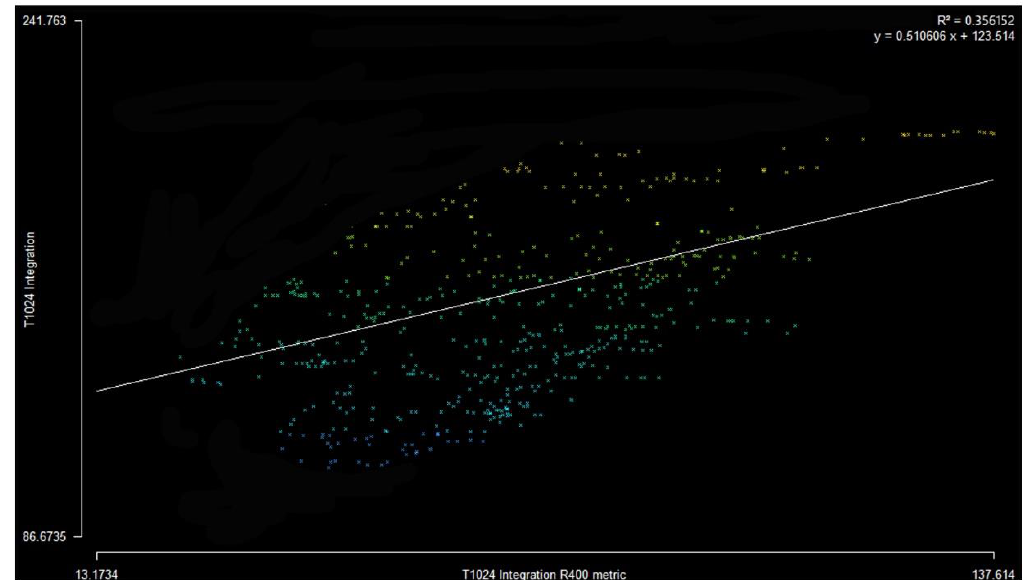
Figure 11. Space syntax model analysis result on Wuzhen: intelligibility value.